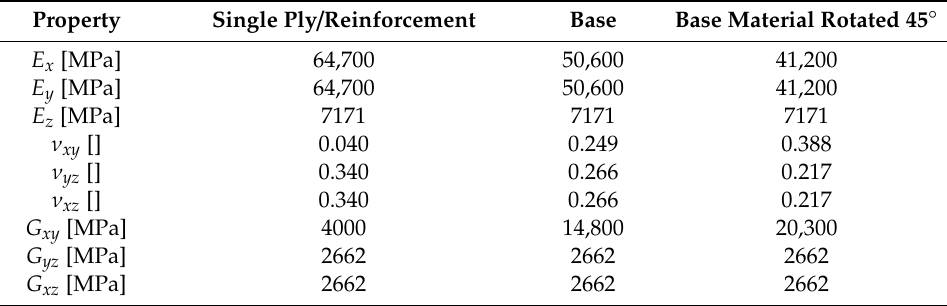
Table 2. Orthotropic mechanical properties of a single ply and laminates.